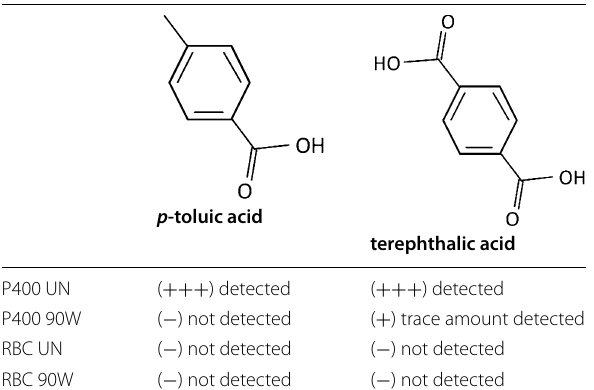
Table 3 Detection of potential bacterial inhibitory compounds ( p -toluic acid and terephthalic acid) in the filtrate of non- ozonized pine 400 (P400 UN), wet-ozonized pine 400 (P400 UN), non-ozonized rogue biochar (RBC UN) and dry-ozonized rogue biochar (RBC